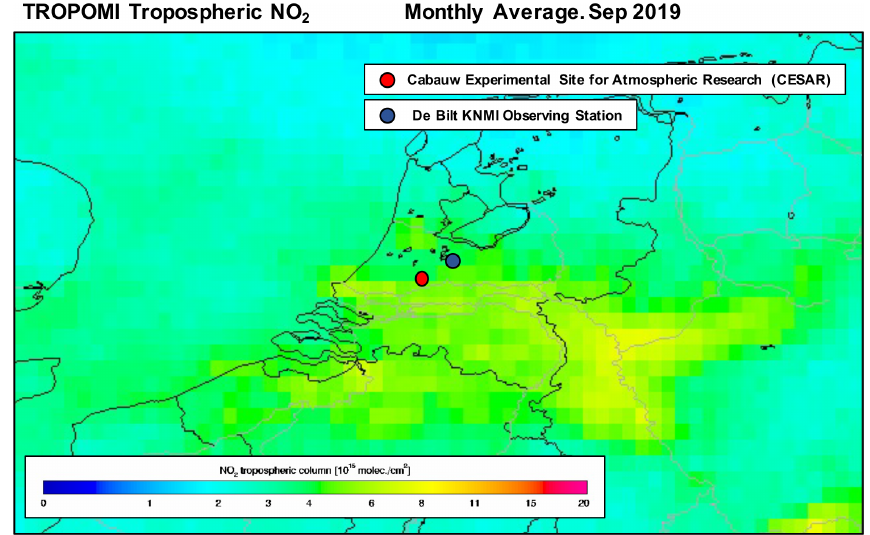
Figure 1. TROPOMI monthly-mean tropospheric NO 2 column (version 1.0) for September 2019. The CESAR and De Bilt, NL, sites are indicated in the image.